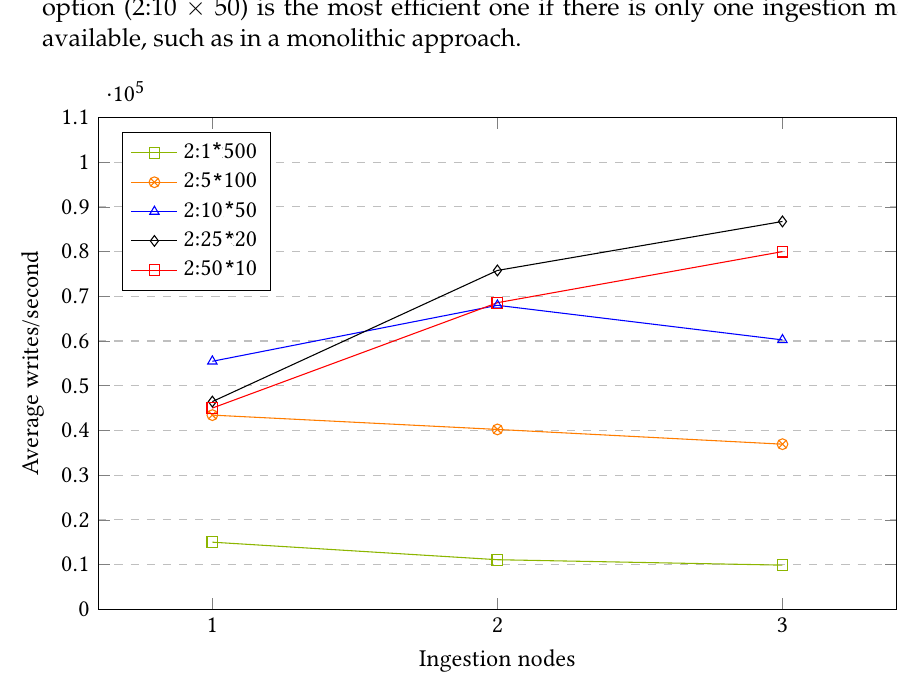
Figure 14. Performance of the different setups for a column length of Figure 3: Scalability of the proposed approach with one to three ingestion nodes, for set ups of 2 as column length.